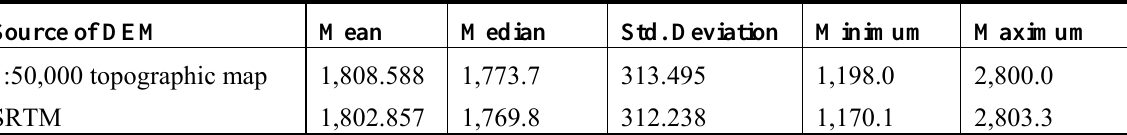
Table 1. Statistic list of different spatial resolution DEMs of the Yangjia river watershed